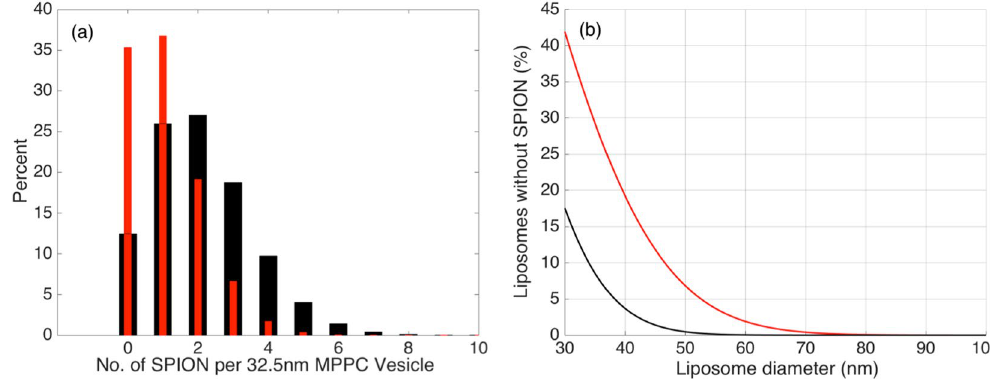
Figure 4. ( a ) Histogram of the expected percentage of 32.5 nm MPPC liposomes (measured average size of magnetoliposomes) containing a certain number of SPION comprising 2 wt% (red) or 4 wt% (black) SPION. ( b ) A fraction of liposomes will contain no nanoparticles when the nanoparticles are stochastically distributed between liposomes. The percentage of liposomes not containing any SPION as function of liposome size has been calculated according to the Poisson distribution when the average liposome comprises 2 wt% (red) or 4 wt% (black) SPION.